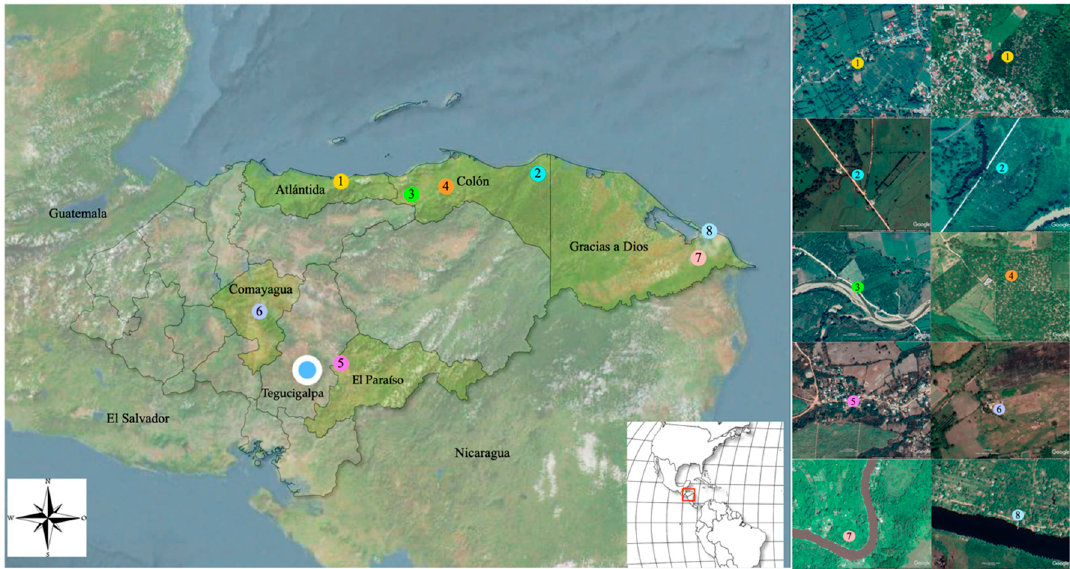
Figure 1. Map of the sites where the mosquito collections were performed in five departments of Honduras. (1) La Ceiba; (2) Iriona; (3) Sonaguera; (4) Tocoa; (5) El Paraíso; (6) Comayagua; (7) Tikirraya; (8) Kaukira. Images from Google Earth.